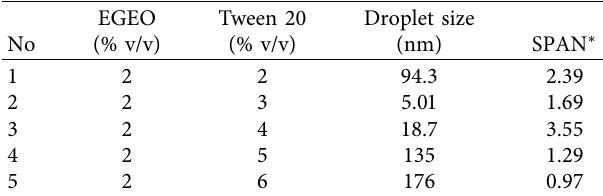
Table 2: Ingredients and size analyses of